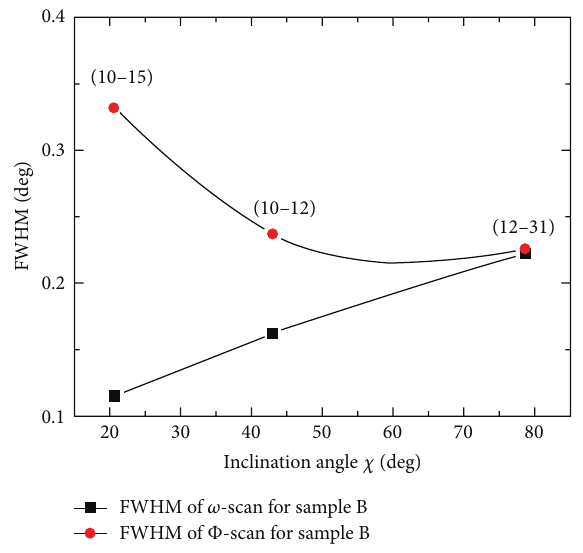
Figure 8: FWHM of Φ and 𝜔 -scans for (10–15), (10–12), (12–31) reflections, recorded in skew diffraction geometry, of the AlInN layer as a function of the inclination angle 𝜒 for sample B (𝑥 = 0.18) . FWHMs of 𝜔 -scan increase with the increment of 𝜒 angle, while those of Φ -scan decrease. The lines are a guide for the